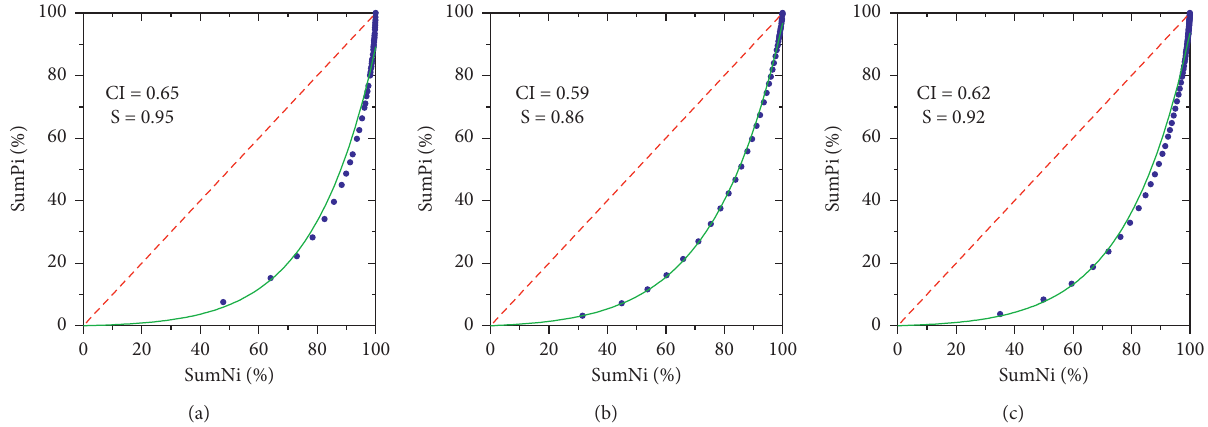
Figure 2: Concentration curve for the Pulan (a), Lasa (b), and Chayu stations (c) from 1970 to